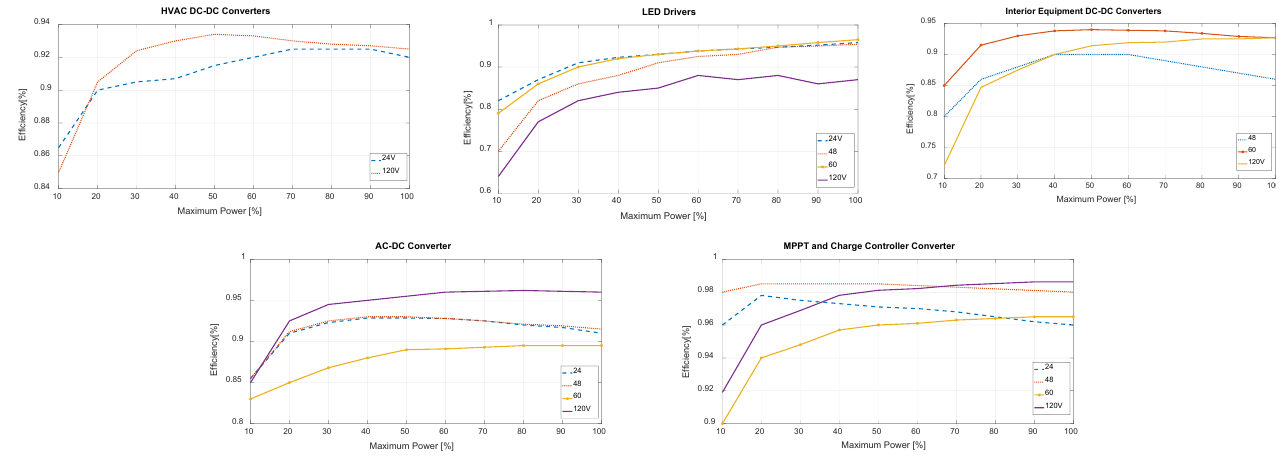
Figure A2. Efficiency curves of the converters.